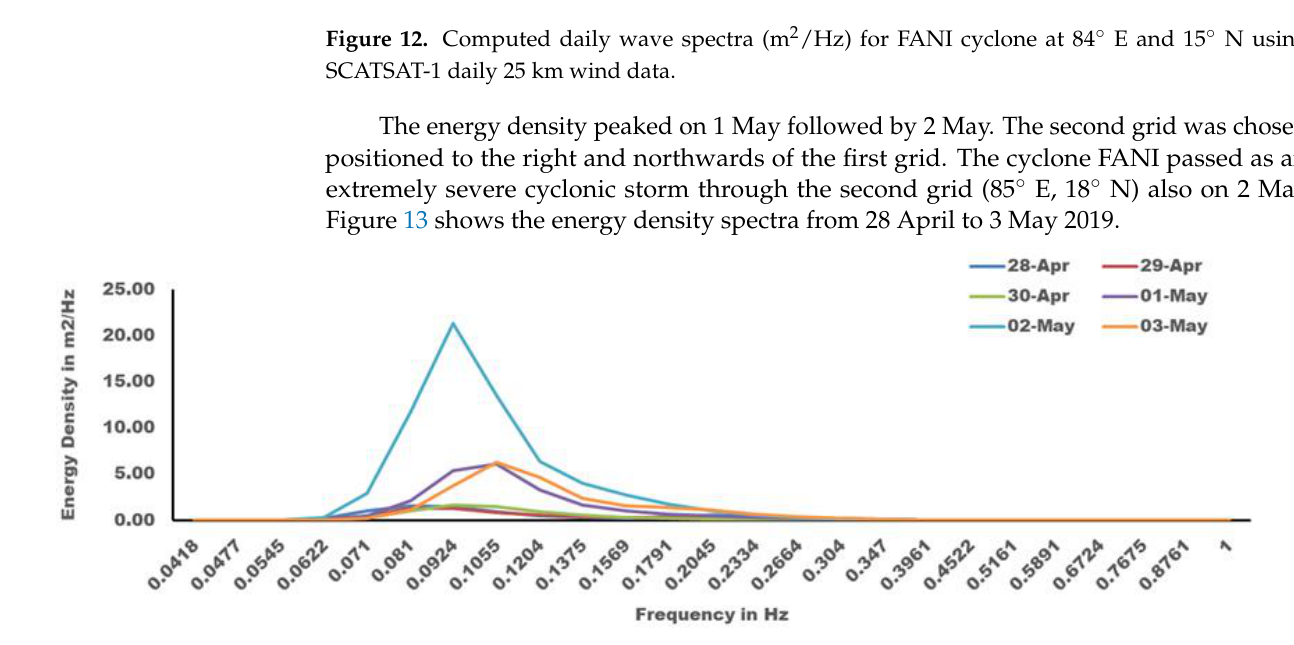
Figure 13. Computed daily wave spectra (m 2 /Hz) for FANI cyclone at 85° E and 18° N using SCATSAT-1 daily 25 km wind data.